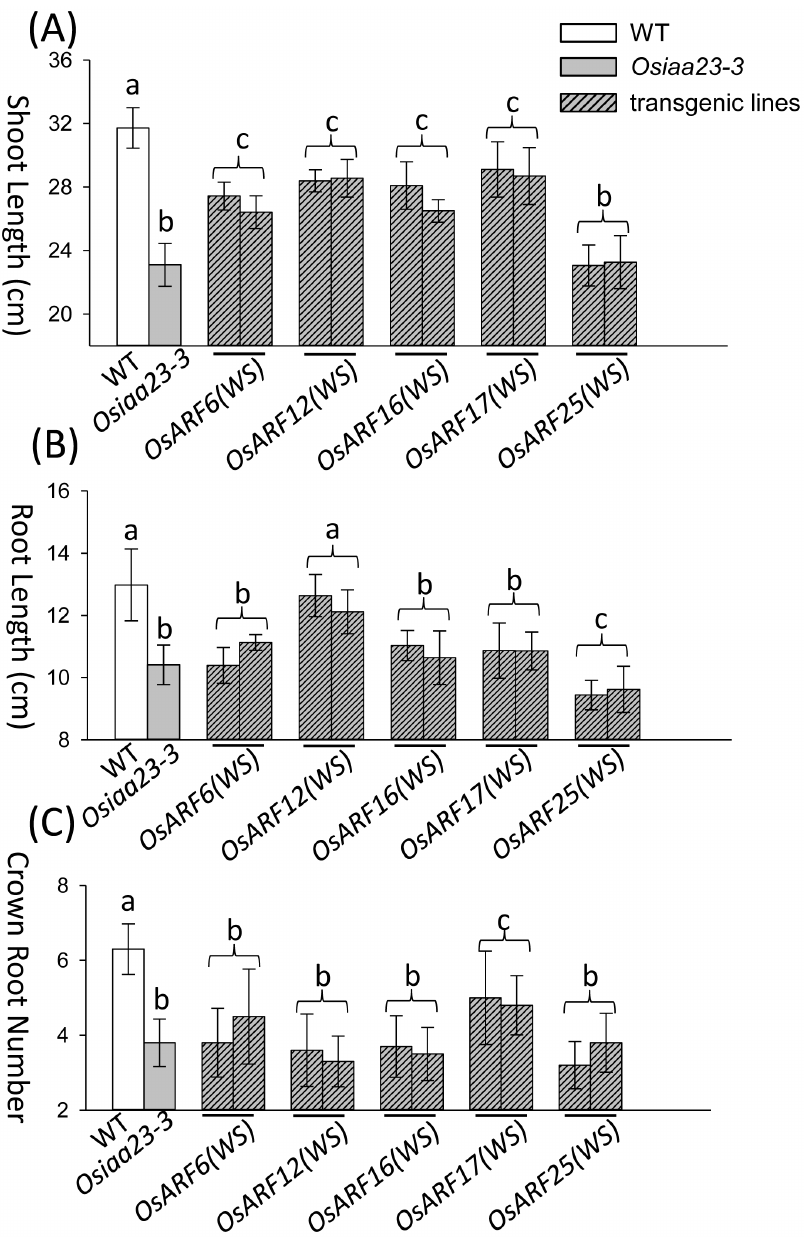
Figure 5. Mutated OsARF(WS)s rescued different defects of Osiaa23-3 . The phenotypes of transgenic rice, over expressing OsARF(WS)s in the Osiaa23-3 background. Two independent lines of transgenic rice over expressing OsARF(WS)s are compared with WT and Osiaa23-3 in the aspects of shoot length (A), root length (B) and crown root number (C). Statistically distinct groups are marked by a, b and c (n=10). doi:10.1371/journal.pone.0085358.g005 Osiaa23-R6 . Bar = 2 cm. (B) Lateral root numbers of revertant substitutions of K to M, V to E, A to G, M to T, W to S and R mutants of Osiaa23 . 1, wild type; 2, Osiaa23 , which has no lateral to Q result in the phenotypes of Osiaa23-1 , Osiaa23-2 , Osiaa23-3 , root; 3, Osiaa23-R5 ; 4-8, the rest of the suppressors. 4, Osiaa23-R1 ; Osiaa23-4 , Osiaa23-5 and Osiaa23-6 respectively. 5, Osiaa23-R2 ; 6, Osiaa23-R3 ; 7, Osiaa23-R4 ; 8, Osiaa23-R6 . Figure S3 The magnification of Figure 1(A). Figure S2 The mutation sites of intragenic suppressors of Osiaa23-3 . The amino acid sequence of OsIAA23, four Figure S4 The expression patterns of selected OsARFs . domains of OsIAA23 are underlined. Red arrow in Domain II Semi-quantitative RT-PCR analysis of OsARF6 , OsARF12 , represents the mutation site of Osiaa23-3 , the other 6 arrows OsARF16 , OsARF17 and OsARF25 expressions in root (R), stem- represent mutation sites of six intragenic suppressors, these sites are distributed between Domain III and Domain IV. The